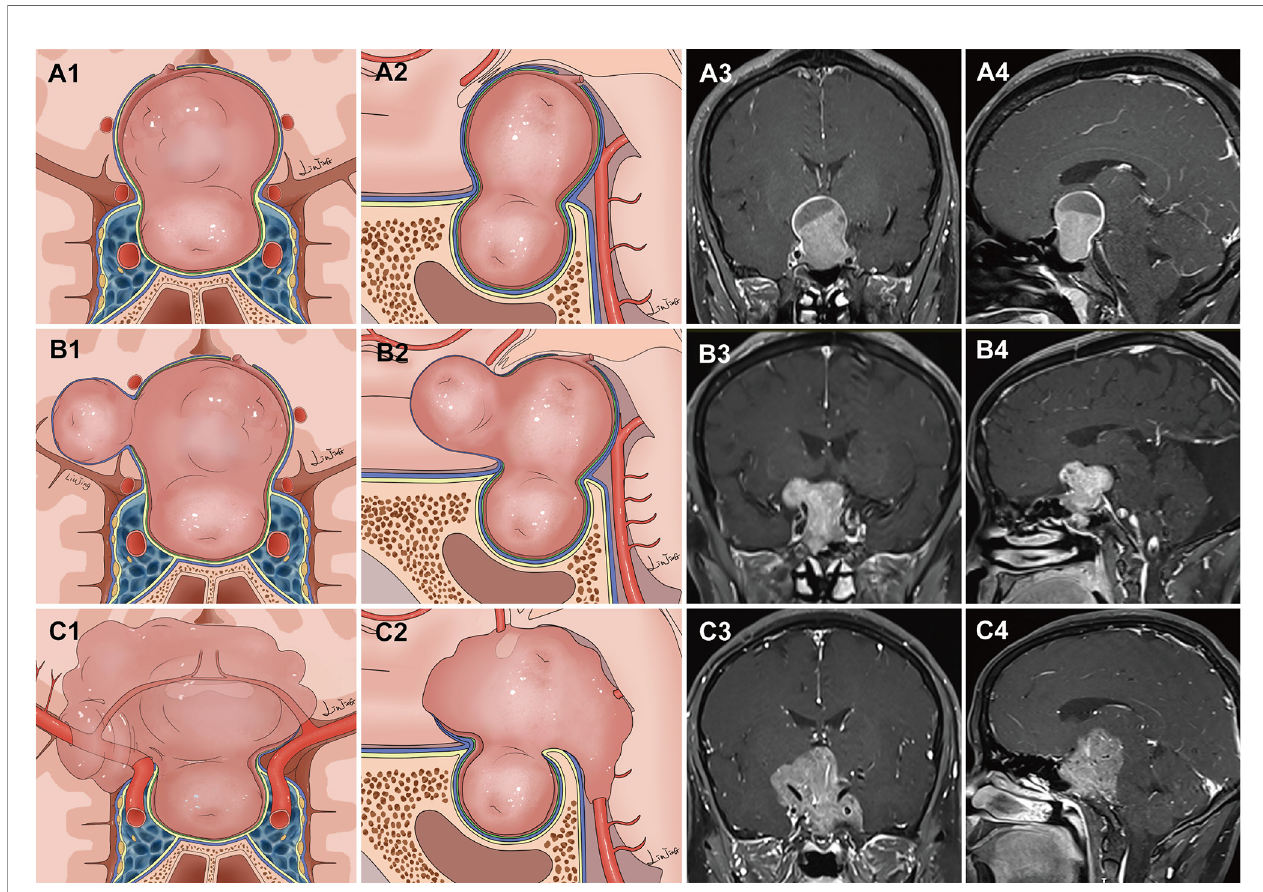
FIGURE 1 | Classi fi cation of pituitary adenomas (PAs) with suprasellar extensions (SSE). Each horizontal panel represents an illustration of coronal and sagittal sectional views, and preoperative and postoperative magnetic resonance images for each type of PA. (A1 – A4) Grade 1a PAs presented as an “ in fl ated balloon ” with expansive growth toward the suprasellar region that pushed the DS and DS-attached residual pituitary gland. (B1 – B4) Grade 1b PAs elevated the DS and DS- attached residual pituitary gland. In some areas beneath the DS, the residual pituitary gland was compressed by the tumor, resulting in it become extremely thin or even absent. The thinning or even absence of the residual pituitary caused the bilayer to become weaker, leading to an inability to resist the intratumoral pressure. This led to the formation of daughter tumors, like a thinning tire forming a bulge. The suprasellar portion of the PAs had an asymmetrically lobulated appearance with clear border. (C1 – C4) Grade 2 PAs broke through the DS to reach the subarachnoid